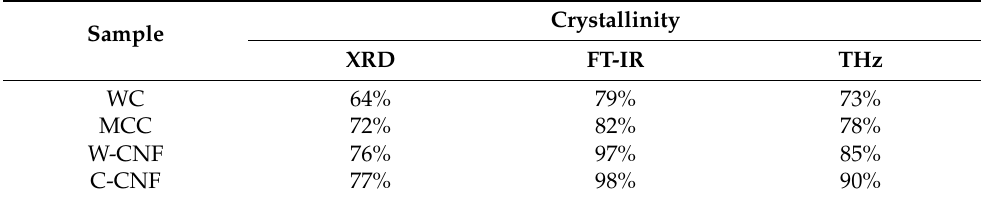
Table 1. Calculation results of crystallinity of four cellulose samples.